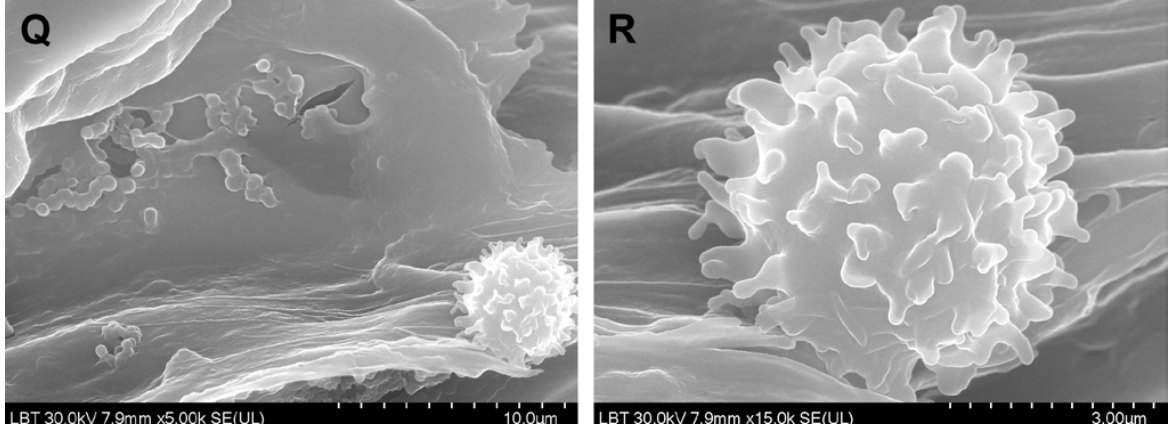
Figure 6. Surface of the nasal mucosa in COVID-19 samples (scanning electron microscopy): ( A – C )—bacterial aggregates (cocci); ( D – F )—fungal aggregates (the arrows indicate budding elements); ( G – I )—mixed aggregates formed by bacteria and fungi; ( I )—detail of ( H ); ( J , K )—nanomicrobial aggregates; ( L )—mucus without microbial elements; ( M )—immune cell mass; ( N )—detail of the preceding figure, which illustrates immunological synapses (arrows); ( O – Q )—immune cells (the arrow indicates immunological synapses); ( R )—detail of ( Q ); (F—fungi; B—bacteria; RBC—red blood cell). Microbial biofilms were identified only in CRSwNP samples (56%, n = 14/25) (Figure